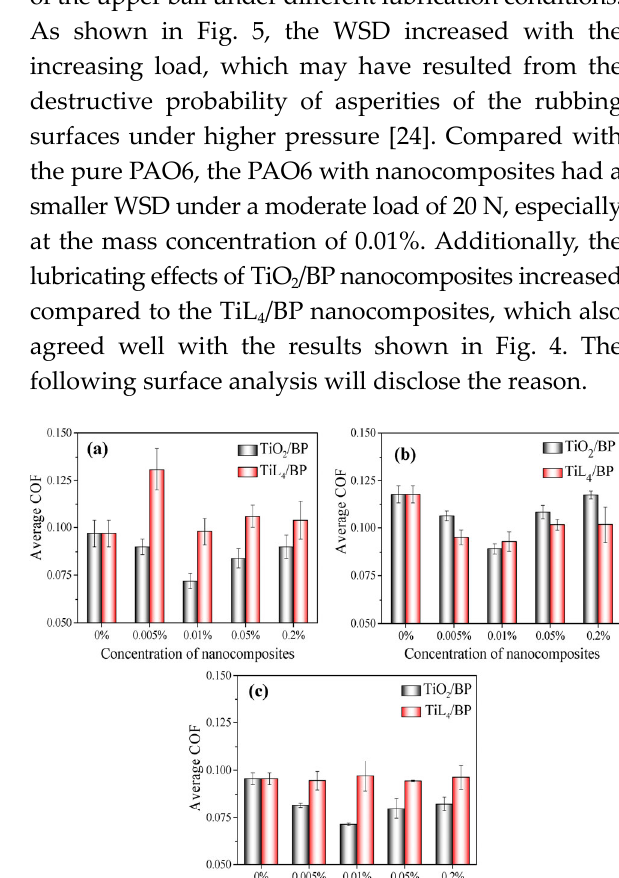
Fig. 3 TEM images of the nanocomposites and digital photos of PAO6 containing different mass concentrations of the nanocomposites after standing for 48 h: (a, b) TiL 4 /BP, and (c, d) TiO 2 /BP.